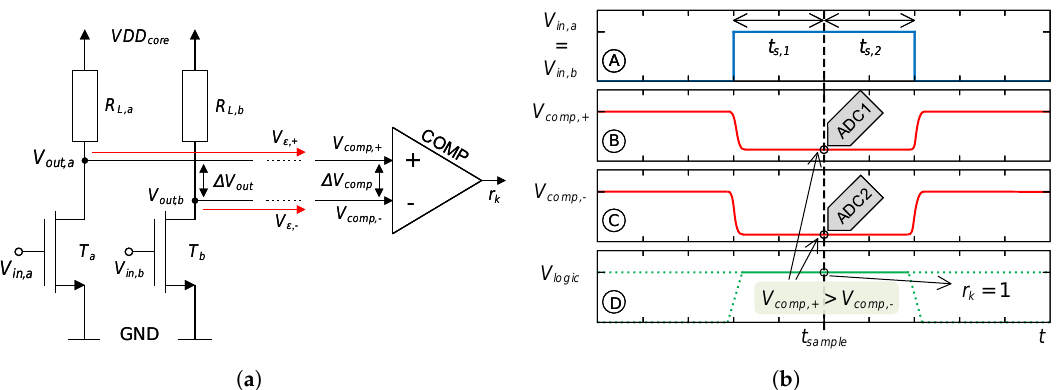
Figure 2. PUF core bit generation using a comparator and corresponding timing diagram for software-based sampling. ( a ) PUF core output voltages to comparator terminals; ( b ) exemplary timing diagram showing the bit generation